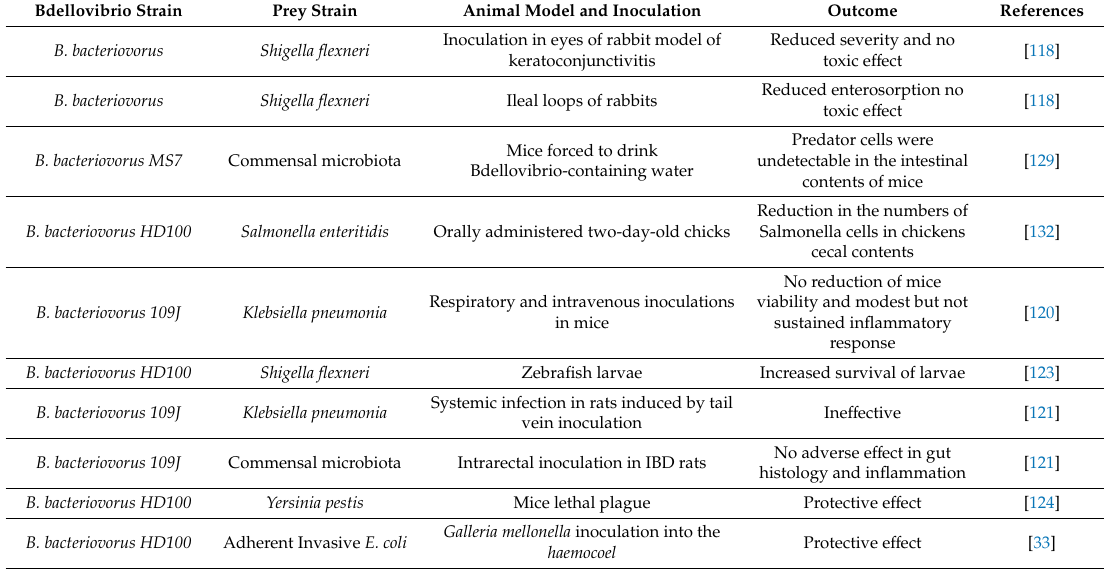
Table 1. In vivo application of